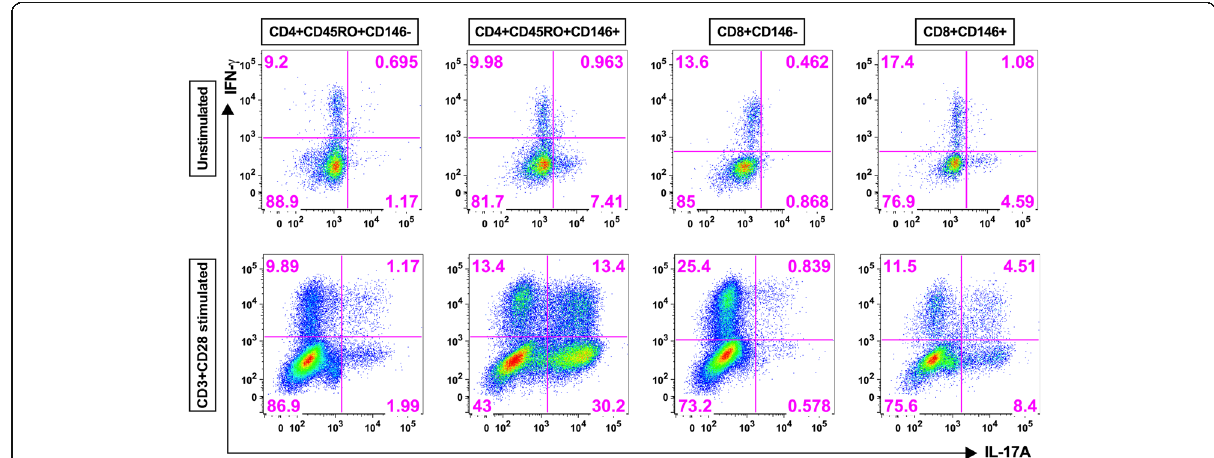
Fig. 3 IL-17A secreting cells are enriched within CD146+ CD4 and CD146+ CD8 subsets. Lymphocytes from whole blood lysis of healthy human peripheral blood were stained with mouse anti Human mAb CD4, CD8, CD45 RO and CD146 as described and sorted using flow cytometer. Sorted cells were finally washed with IMDM media and plated in 96 well flat bottom culture plate coated with purified anti-human CD3 and CD28 antibodies. Cells were incubated for 5 days; cultured cells were re-supplemented for the last 4 h of incubation with IMDM + 10% FCS and PMA/Ionomycin in the presence of brefeldin-A and collected to perform intracellular cytokine staining for IL-17 and IFN- γ